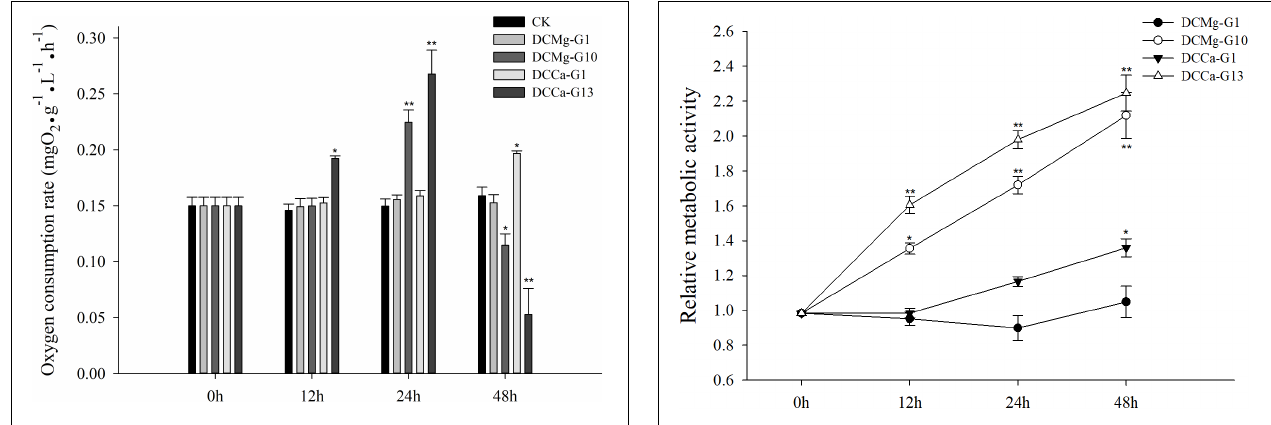
FIGURE 11 | Acute metabolism of JSCs under extreme Ca 2 + and Mg 2 + concentrations. Results show metabolism activity of test groups normalized to the 0 h group. Bars (mean ± SE, n = 3) with an asterisk denote a significant difference ( ∗ P < 0.05, ∗∗ P < 0.001) between the test groups and CK.